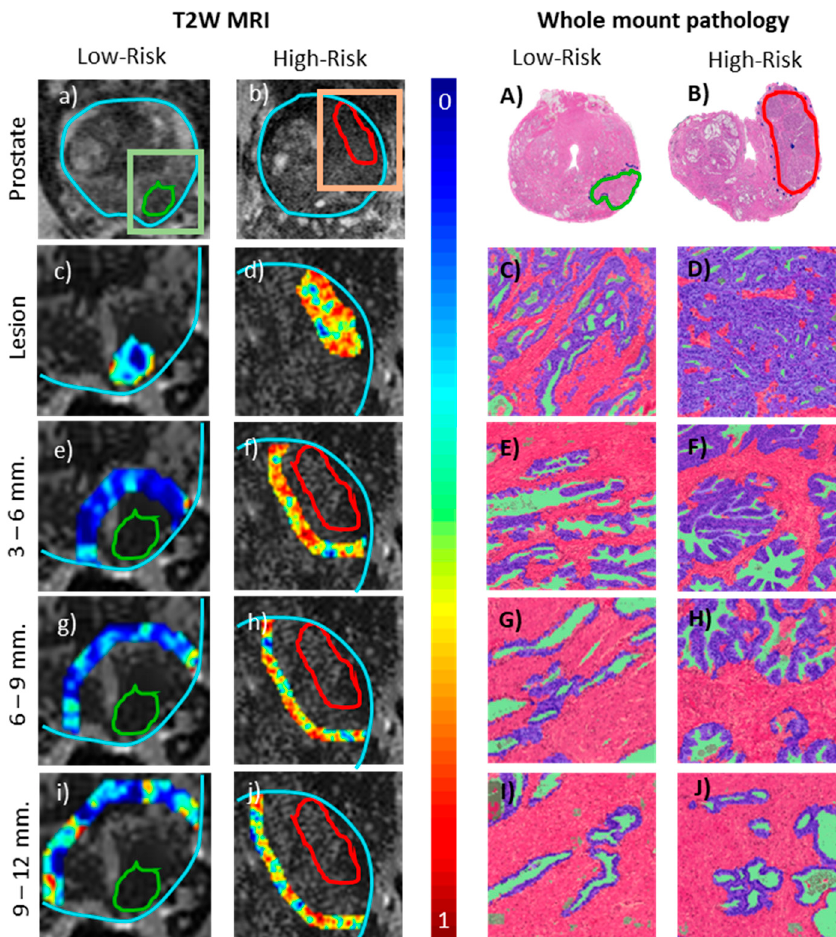
Figure 3. Peri-tumoral and intra-tumoral regions of interest (ROIs) overlaid with representative radiomic features on T2W MRI showing differential expression between low ( a ) and high ( b ) D’Amico risk prostate cancer patients, along with corresponding whole mount histopathology ( A ) and ( B ). Gabor feature map within the lesion ( c ) and ( d ) and representative pathology from corresponding region ( C and D ) with epithelium (purple), lumen (green) and stroma (pink) segmented. Similarly, Haralick (3–6 mm) ( e ) and ( f ), CoLlAGe (6–9 mm) ( g ) and ( h ) and Haralick (9–12 mm) ( i ) and ( j ) radiomic features within peri-tumoral annular rings within the prostate boundary (cyan). Representative peri-tumoral tissue compartments segmented on corresponding pathology are shown in ( E – J ). Quantitative feature values are provided in Supplementary Table